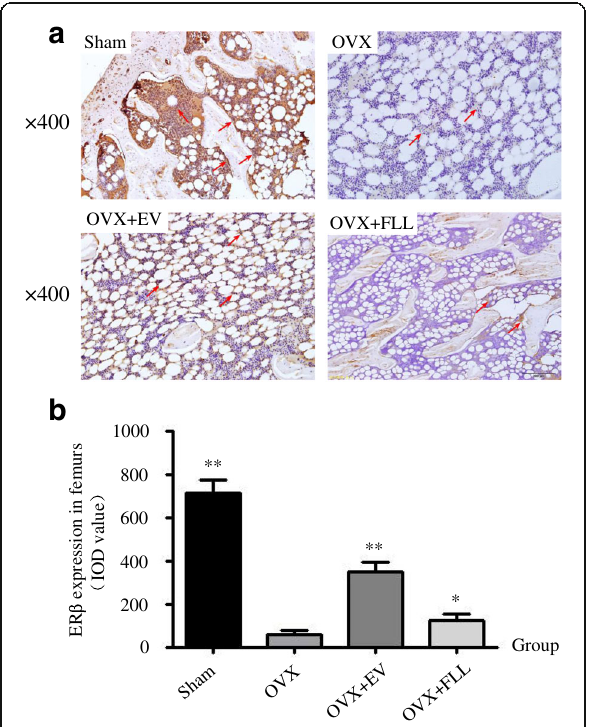
Fig. 2 The representative images ( a ) and images analysis results of immunohistochemical staining ( b ) showing the effect of FLL on ER β expression in the femurs of the rats. The arrows illustrated the expression and distribution of ER β . Data are presented as